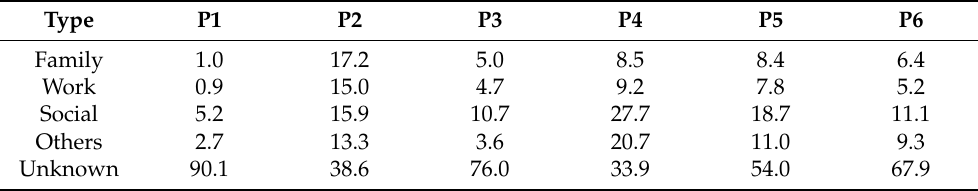
Table 2. The percentage of confirmed cases according to infection relationship.